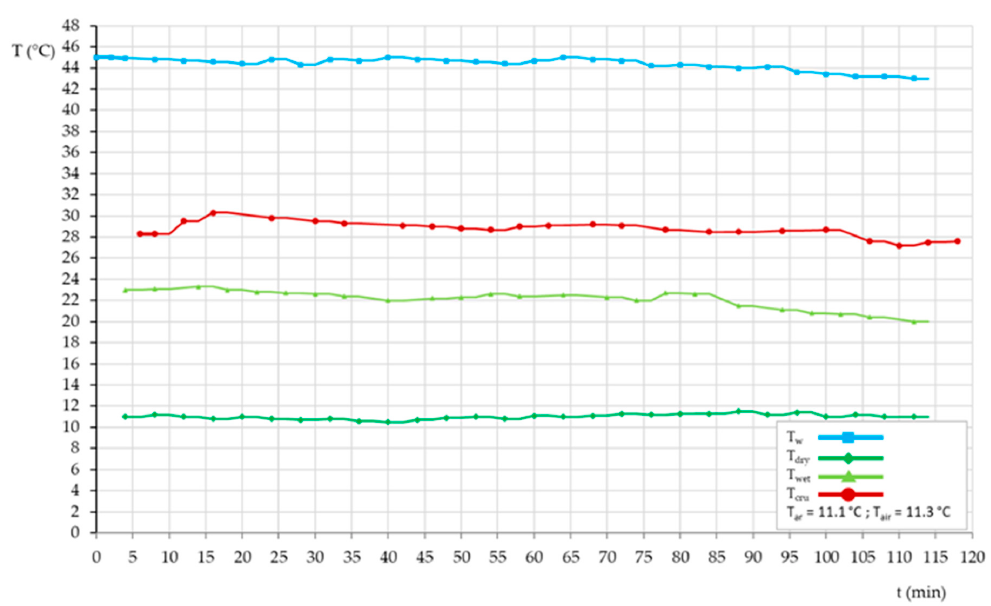
Figure 4. Evolution of the temperature during the processing of a batch of ‘Picual’ olives. Each point represents a registration on one of the 4 different temperature measurement points: fruit temperature at the exit of the hopper (T dry ), water temperature in the washing tub (T w ), temperature of the fruit exiting the washing tub (T wet ), and temperature of the crushed olives (paste) before entering the malaxer (T cru ). On arrival, the fruit temperature was 12.8 ± 0.3 ◦ C. The outdoor temperature was 11.3 ◦ C at 9